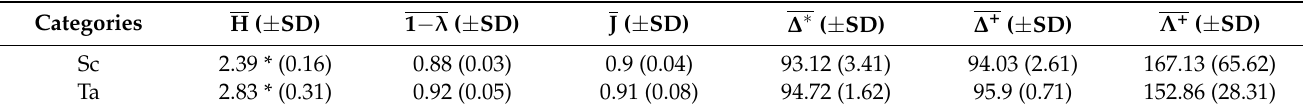
Table 4. Comparison of the mean diversity indices of the avifaunal community between the Sc and Ta habitats. For habitat labels, cf. Table 1. For diversity indices symbols, cf. Table 2. SD stands for Standard Deviation. An asterisk represents a statistically significant difference ( p -value < 0.05) between the two habitats.